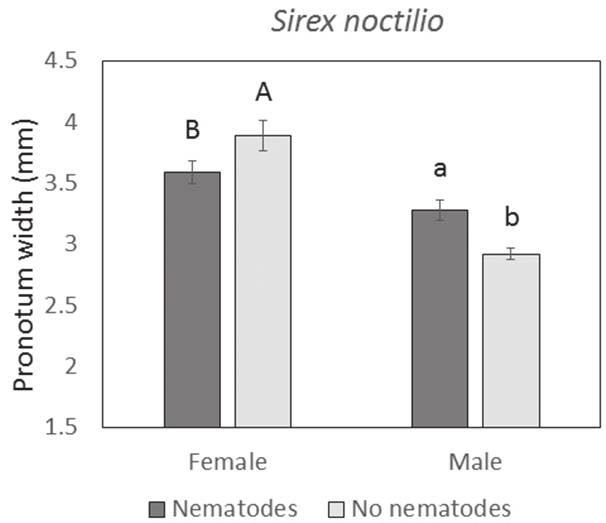
Figure 2. Mean body size (+ SE), measured as pronotum width, for S. noctilio males or females para- sitized by the nematode D. siricidicola or not. Different letters (comparing either capital letters or compar- ing lower case letters) demonstrate significant differences within